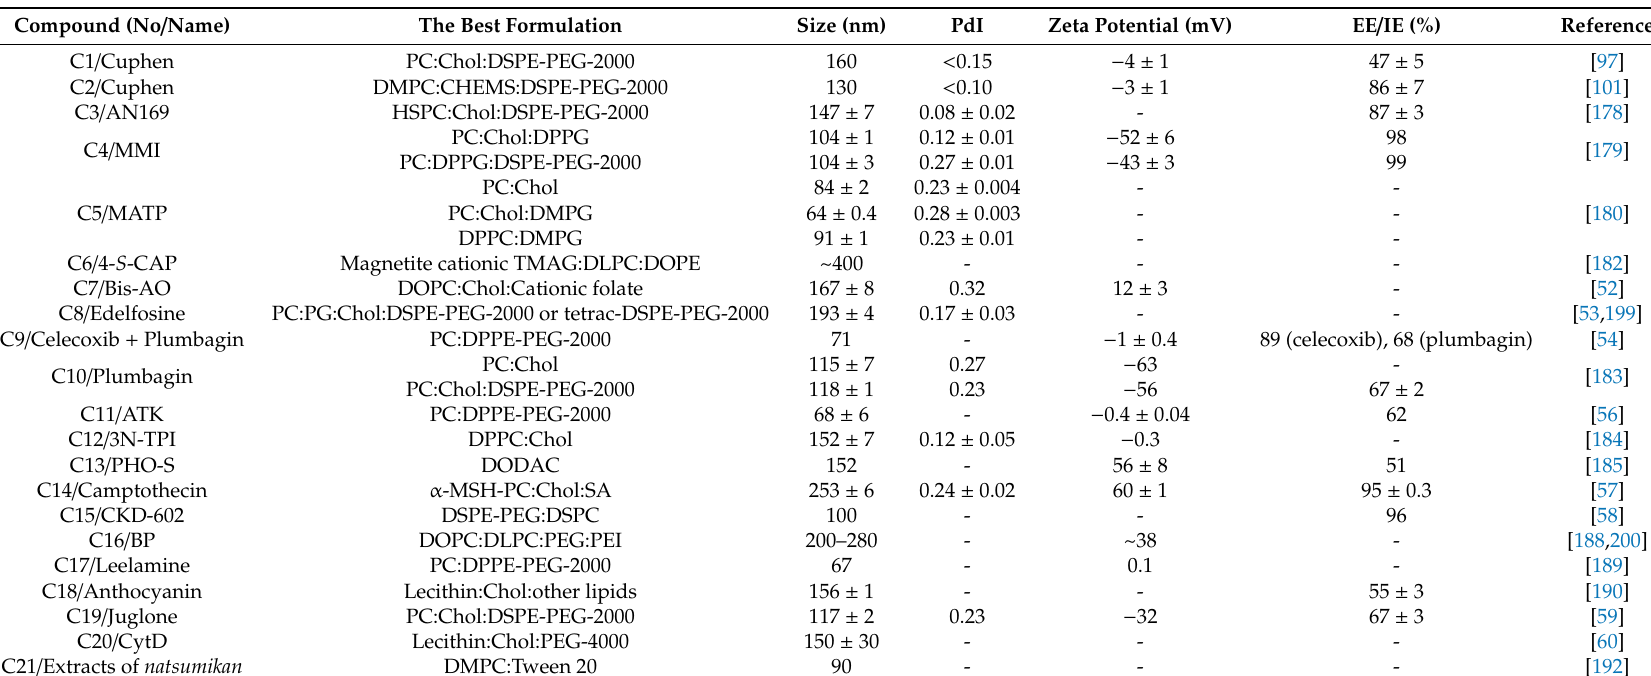
Table 3. Physicochemical properties of the most suitable liposomal formulations for di ff erent compounds with antitumor